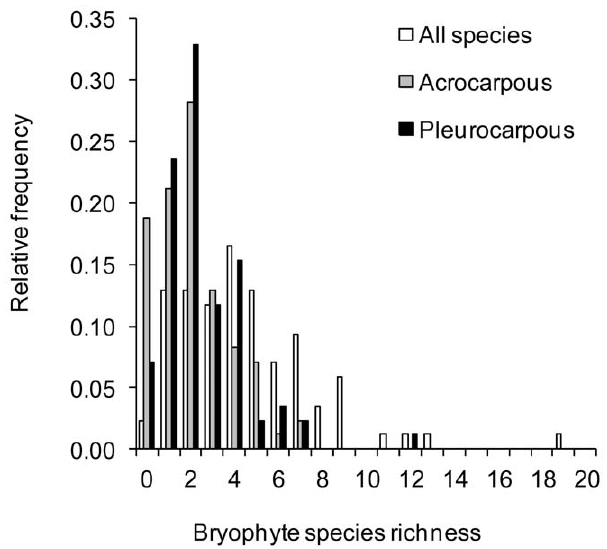
Figure 1. Frequency distribution of bryophyte species. Relative frequency distribution of the species richness of all, pleurocarpous, and acrocarpous bryophyte species per 16 m 2 plots in grasslands ( n =85).